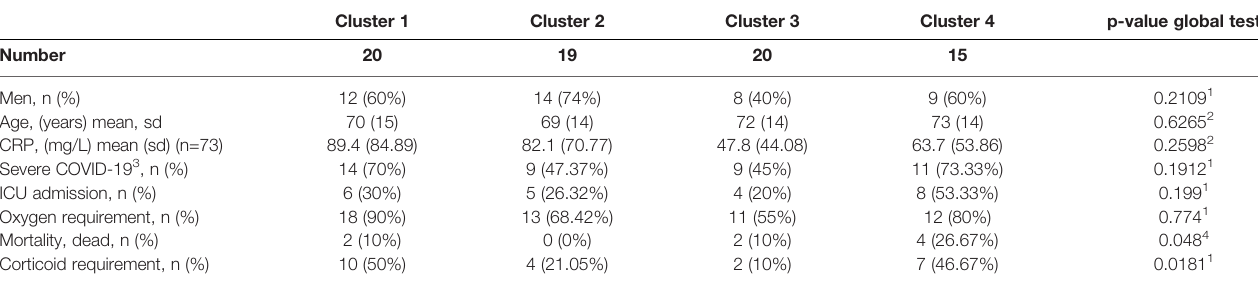
TABLE 4 | Overall comparison of clinical and biological characteristics between the